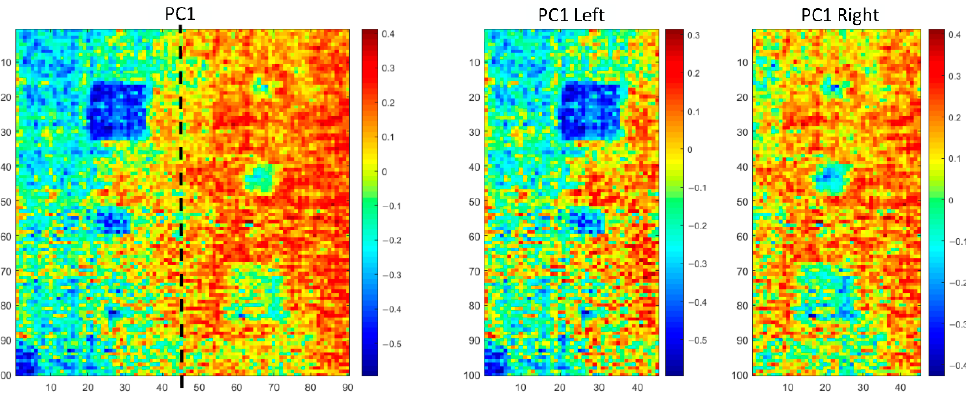
Figure 15. Schematic diagram of image segmentation with the improved SNR calculation. Table 3. SNR values based on half images.